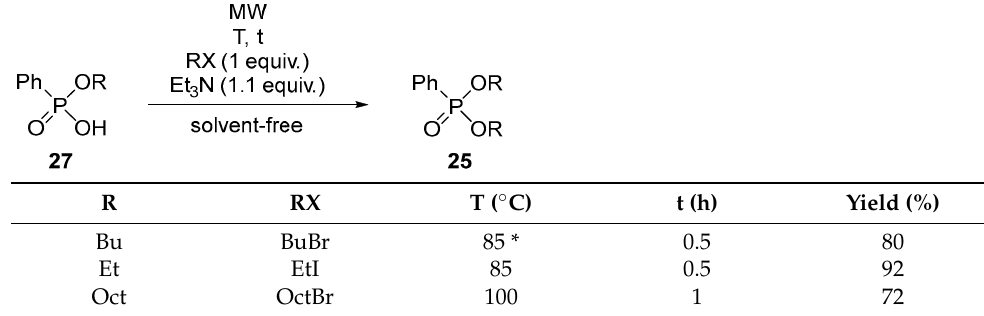
Table 6. Alkylation of phenylphosphonic monoesters ( 27 )—synthesis of dialkyl phenylphospho ‐ nates ( 25 ).